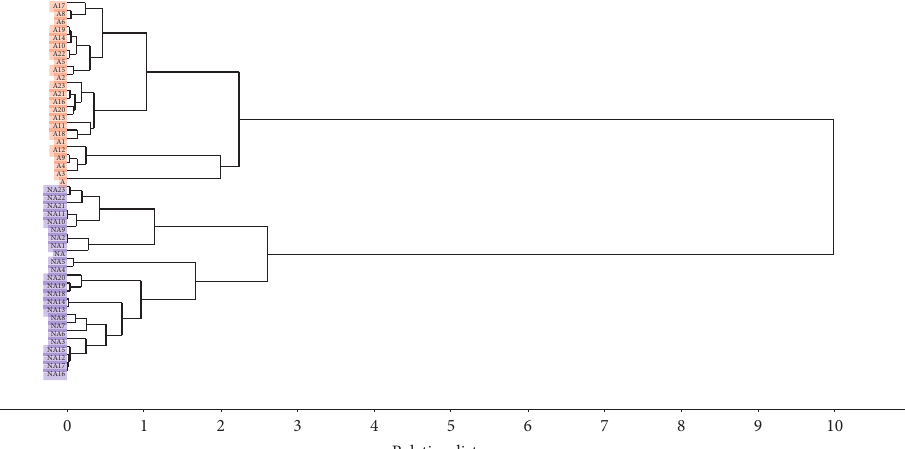
Figure 2: Dendrogram from an HCA with single linkage of adulterated and nonadulterated honey samples using the squared Euclidean distance.